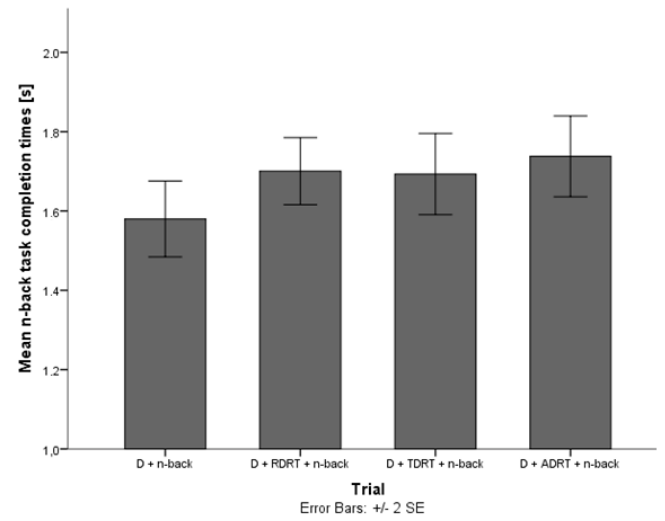
Figure 11. Mean task completion times for trials without and with DRT stimuli [38].